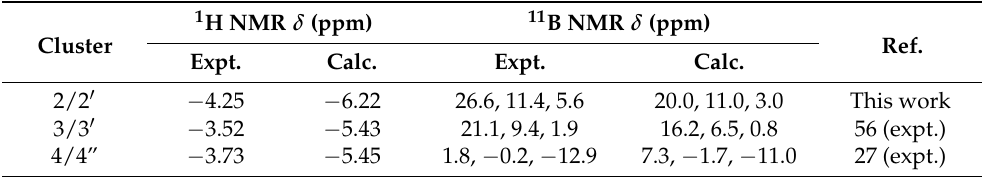
Table 2. Experimentally observed and calculated 1 H and 11 B chemical shifts for 2 – 4 species and 2 (cid:48) – 4 (cid:48) models, respectively.